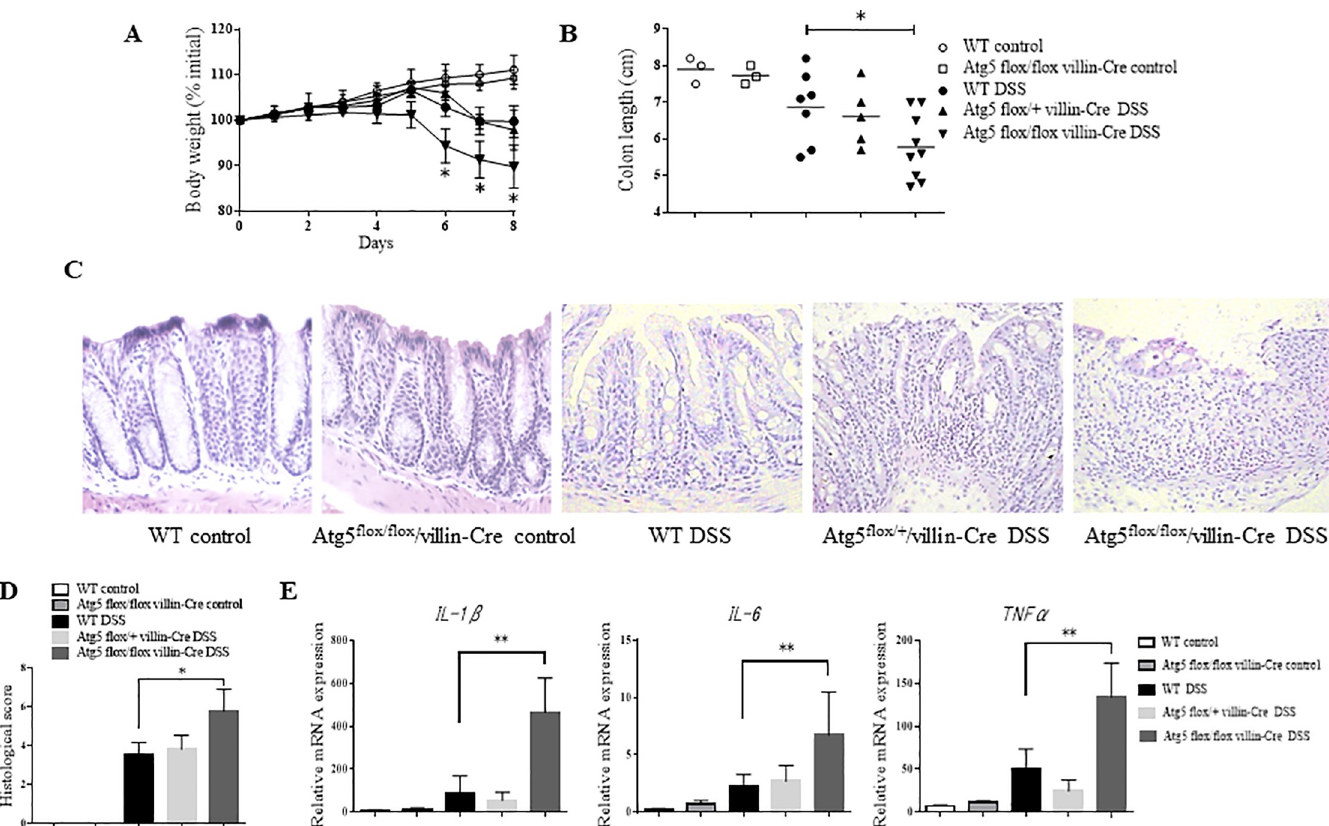
Fig 1. Atg5flox/flox/villin-Cre mice are more sensitive to DSS-induced colitis than WT mice. (A) Acute colitis was induced in WT, Atg5flox/+/villin-Cre, and Atg5flox/flox/villin-Cre mice by oral feeding of DSS (n = 5–9 per group). Weight loss during colitis progression is shown. Mice with colitis were euthanized on day 8, and severity of DSS-induced colitis was determined by colon length (B) and histological score (D). (C) Histological changes in the middle segment of the colon. (E) mRNA expression of proinflammatory cytokine genes in colon tissues quantified by qPCR. Data are expressed as the relative abundance of GAPDH. Results are expressed as the mean ± SD; � p < 0.05, �� p <